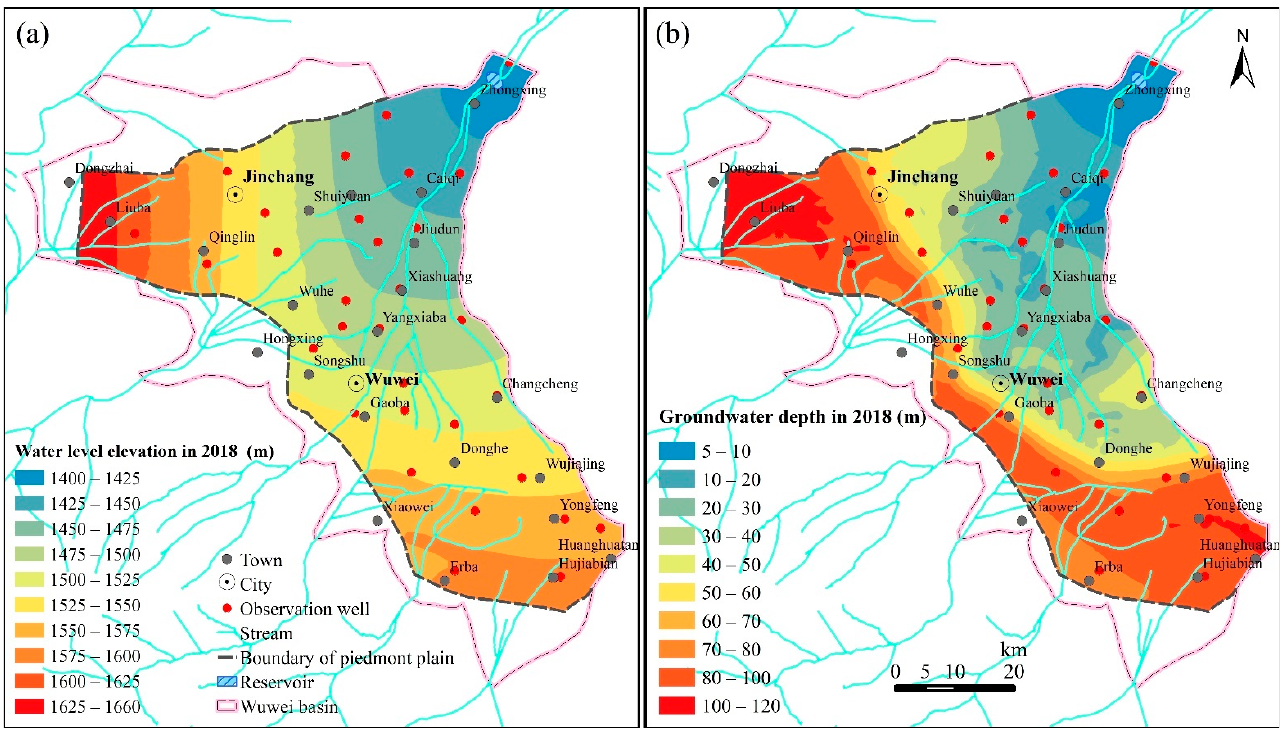
Figure 2. Distribution of ( a ) water level elevation in 2018, ( b ) groundwater depth in 2018.